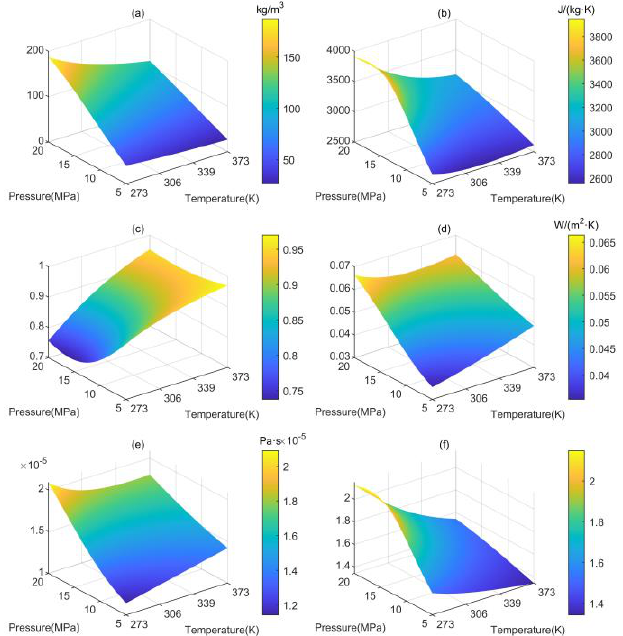
Figure 4. Physical property parameters of methane: ( a ) density, kg/m 3 ; ( b ) isobaric heat capac- ity, J/(kg · K); ( c ) compressibility factor (Z); ( d ) thermal conductivity, W/(m · K); ( e ) viscosity, Pa · s; ( f ) specific heat capacity, J/(kg · K).